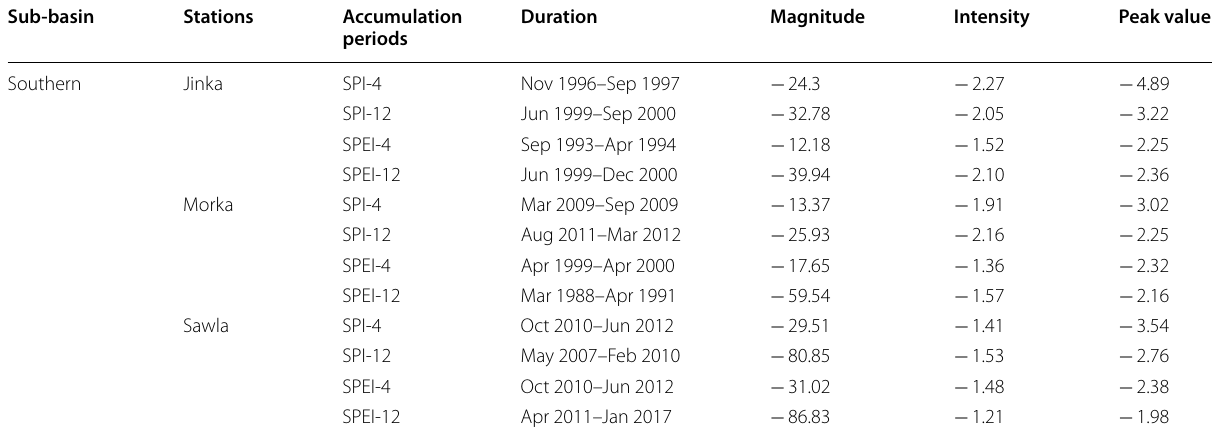
Table 7 The significant drought events (SPI/SPEI 1981 to 2017